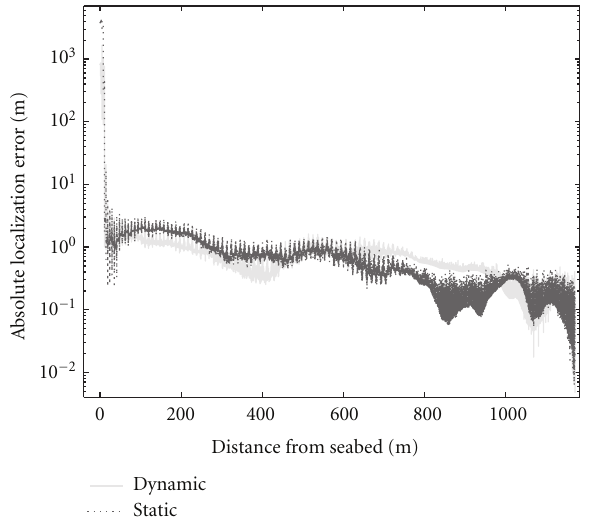
Figure 17: Mean localization error (in global coordinates) as a function of distance from the seabed, for both static and dynamic